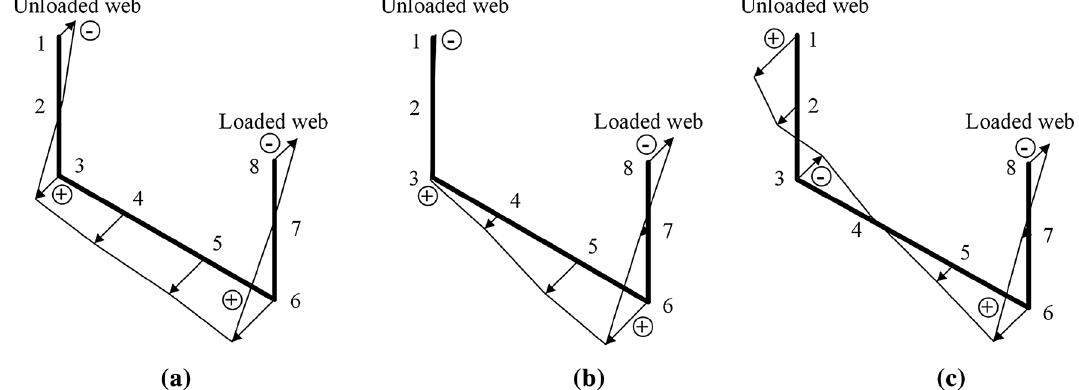
Fig. 12 Distributions of measured longitudinal bar strain around mid-span cross-section: a MEM-1:5, b MEM-1:1, and c